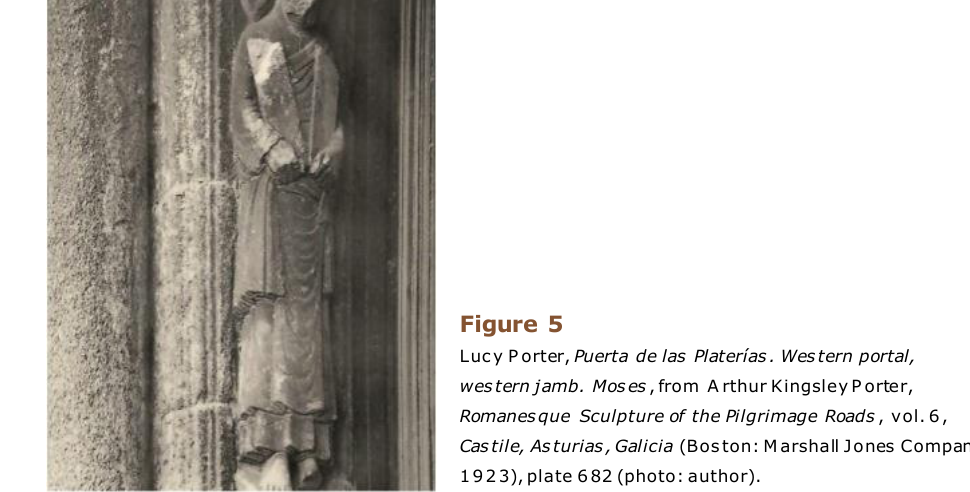
Lucy Porter, Puerta de las Platerías. Western portal, western jamb. Moses , from Arthur Kingsley Porter, Romanesque Sculpture of the Pilgrimage Roads , vol.